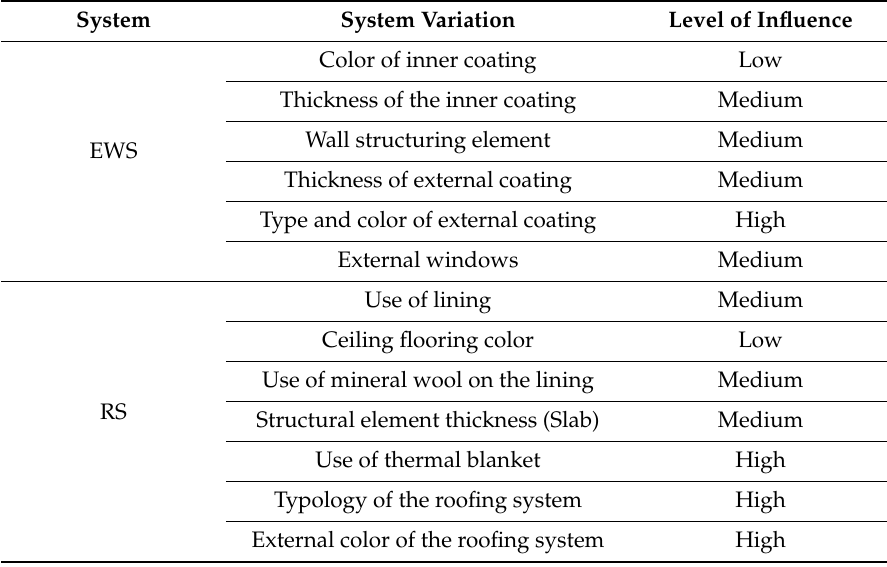
Table 25. Influence level of the variations adopted in thermal performance in relation to the reference